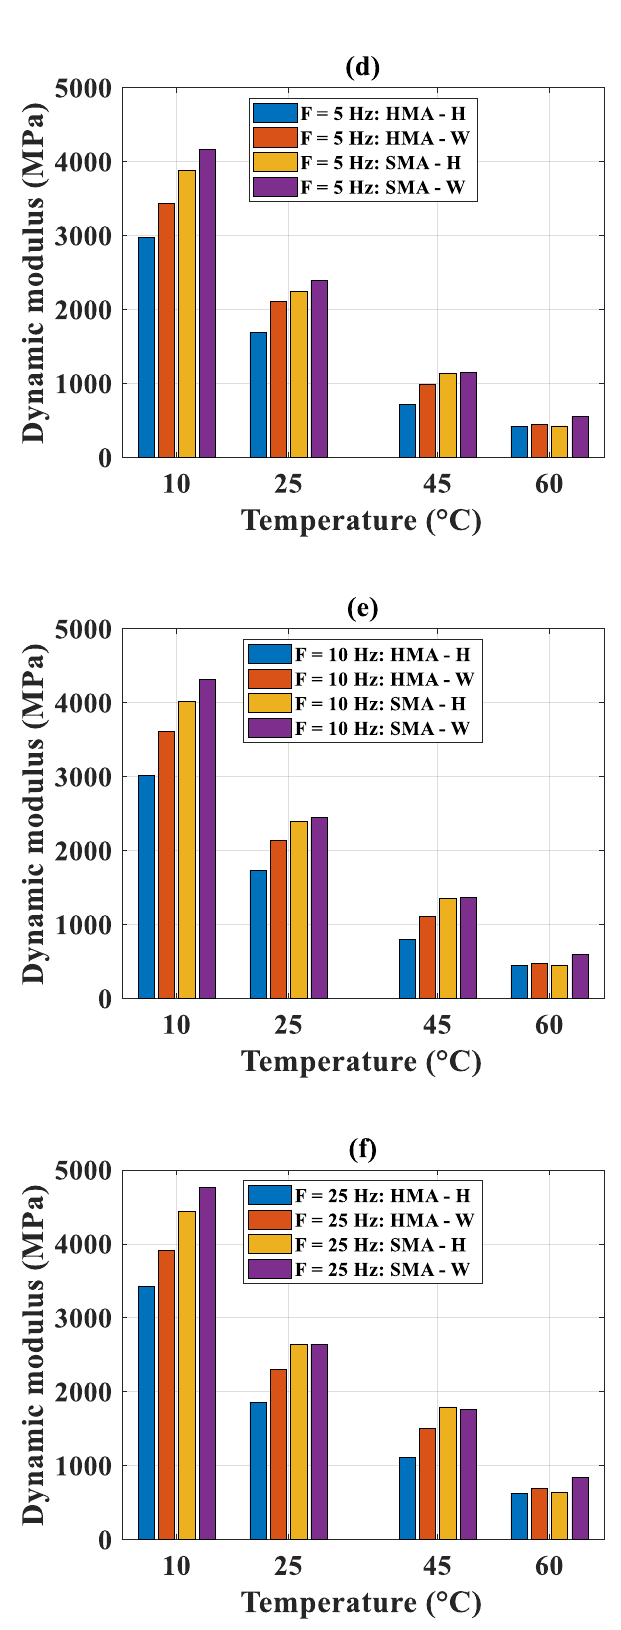
Figure 5. Experimental results of dynamic modulus |E*| in function of the test temperature for different frequencies: ( a ) 0.1 Hz; ( b ) 0.5 Hz; ( c ) 1 Hz; ( d ) 5 Hz; ( e ) 10 Hz; ( f ) 25 Hz.